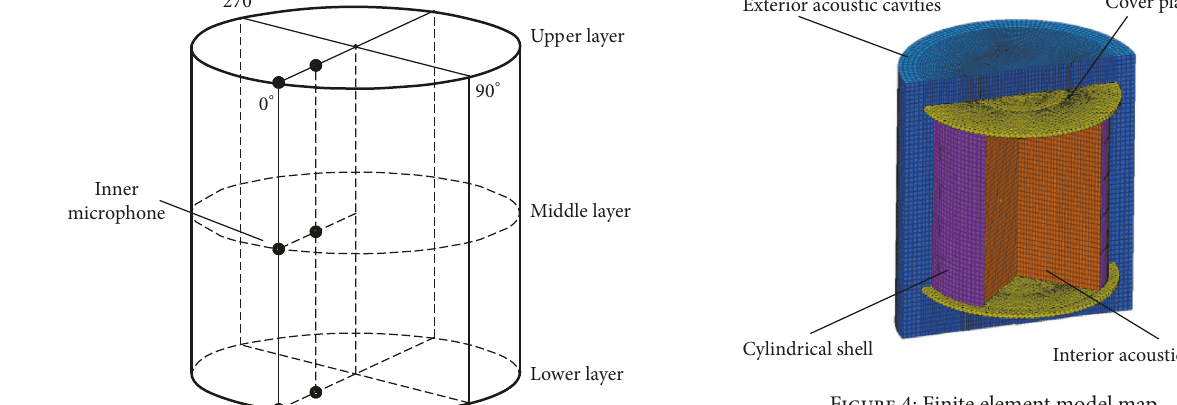
Figure 4: Finite element model map.